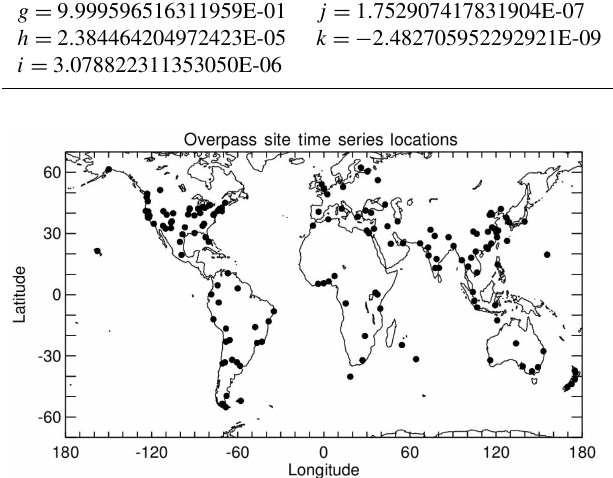
Figure A3. Map of locations in Table A4. Figure map created with IDL ® .